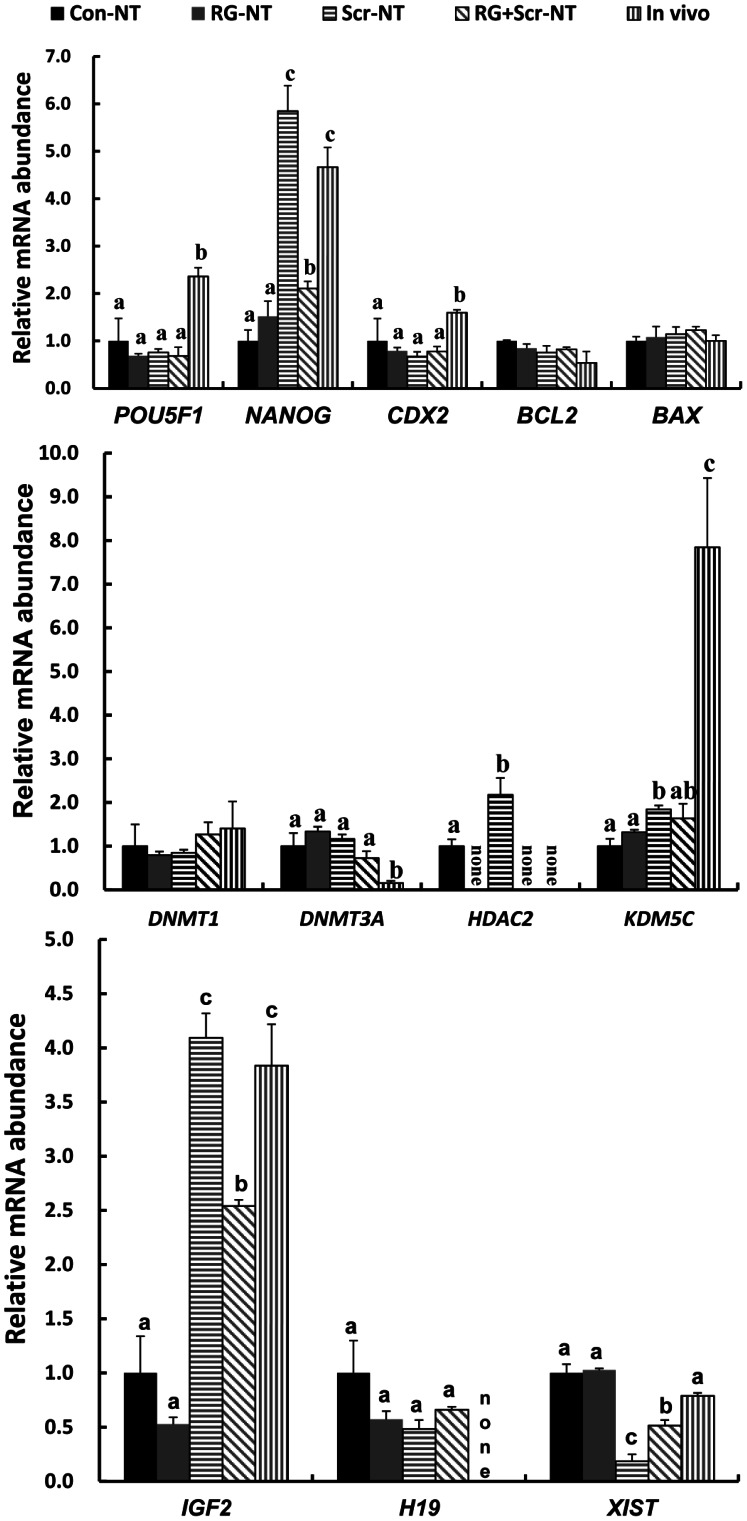
Comparison of transcription levels of twelve selected genes in blastocysts after treatment by RG108 and/or scriptaid.Con-NT, RG-NT, Scr-NT and RG+Scr-NT indicated groups untreated, RG108 alone, scriptaid alone or by RG108 and scriptaid simultaneously, respectively. In vivo produced blastocysts (in vivo) served as the reference. Bars replaced by the “none” indicated no detected transcription. Letters of “a, b, c” on bars referred to significant (P<0.05) differences. Means labeled with the same letter or no letters didn’t differ from each other (p>0.05) and without the same letter differed significantly (p<0.05).